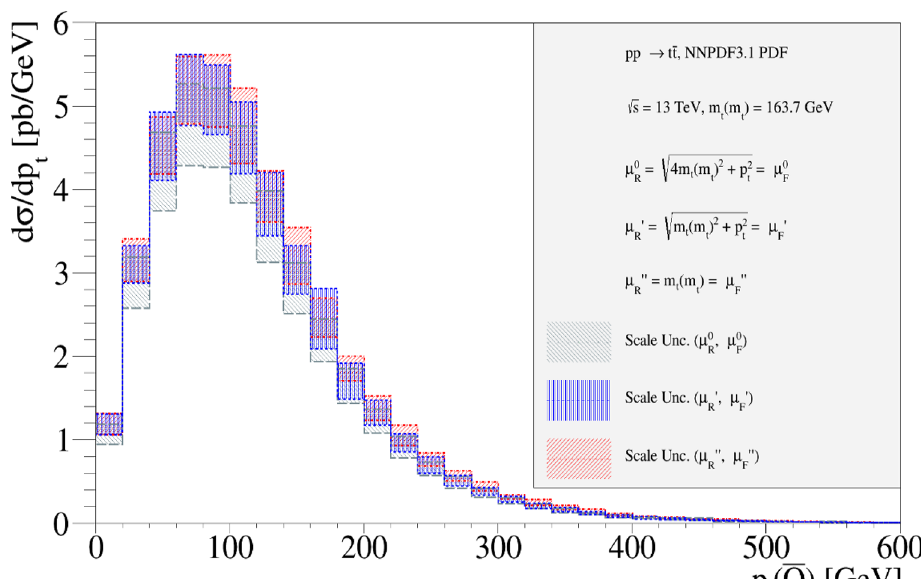
Figure 17 . The NLO differential cross-sections at the LHC ( as a function of the p T of the produced antiquark with mass renormalized in the MS scheme, using as input NNPDF3.1 NLO PDFs with their α S ( M Z ) value and α S evolution, and different ( µ R , µ F , µ m ) combinations: in the upper panel central predictions with static scale µ R = µ F = m t ( m t ) and µ m = m t ( m t ) are compared to those with dynamical scales µ R = µ F = those with dynamical scales µ R = µ F = Scale uncertainty bands, shown in the lower panel only for the cases with µ m = m t ( m t ) ), refer to 7-point ( µ R , µ F ) variation of factors (1/2, 2) around the central